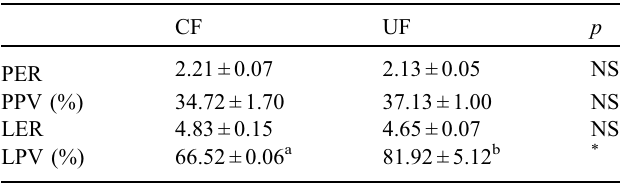
Table 5. Mean values (±SE) of PER (Protein ef fi ciency ratio), PPV (Protein productive value), LER (Lipid ef fi ciency ratio), and LPV (Lipid productive value) estimated in CF ( fi sh group in control-RAS) and UF ( fi sh group in Ulva -RAS) ( n =3).